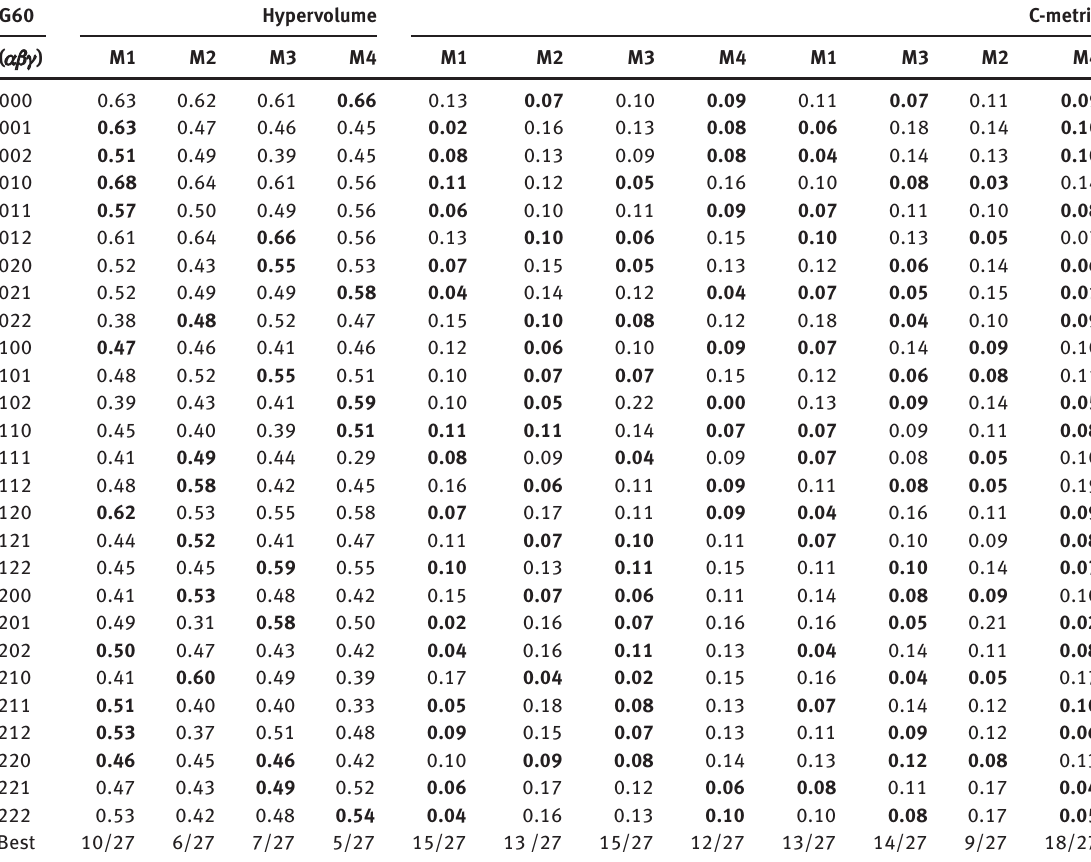
Table 5: G 60 – Hypervolume and C-metric. G60